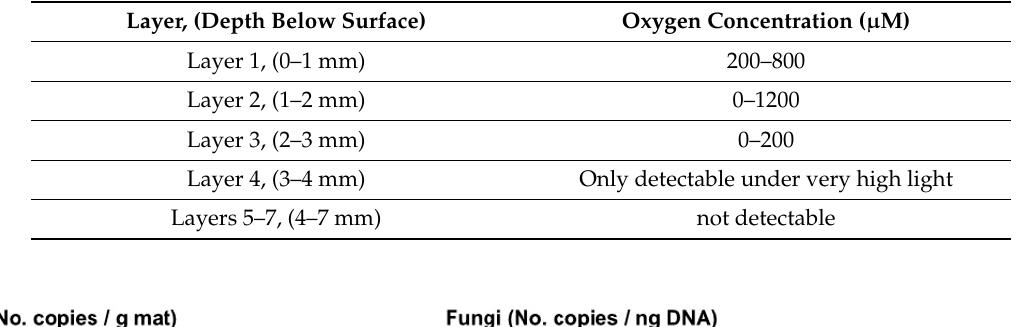
Table 1. Ranges of oxygen concentration in hypersaline microbial mat from different depths. The depths shown are Layer 1 (0–1 mm from surface), Layer 2 (1–2 mm from surface), Layer 3 (2–3 mm from surface) and Layer 4 (3–4 mm from surface).